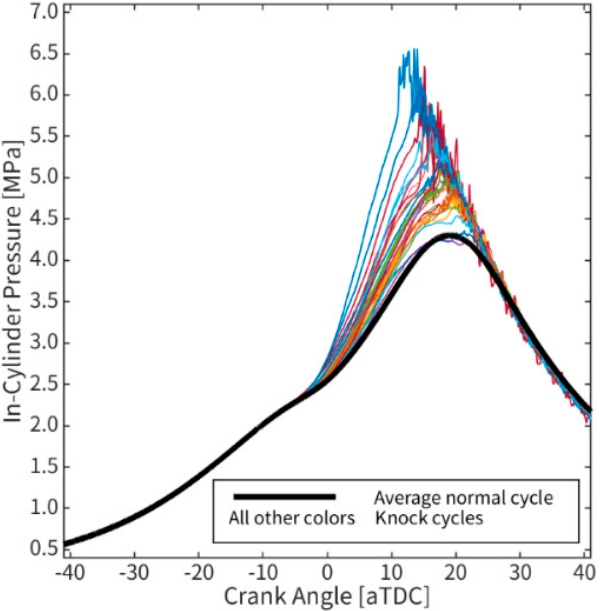
Figure 4. In-cylinder pressure traces of 16 knock cycles and the average traces of 91 normal cycles in Point 6 (spark timing: − 30° aTDC).